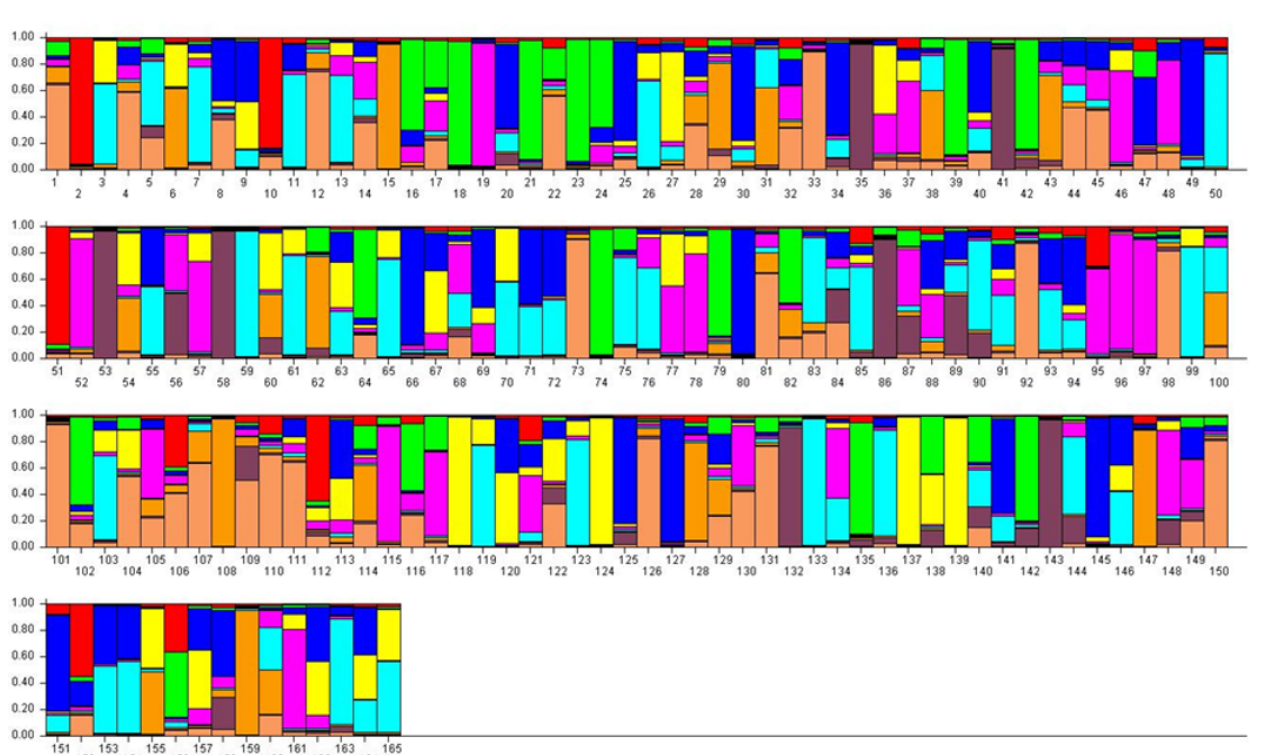
Figure 4. Bar plot of the results from a Bayesian genetic structure analysis with K = 9, dusty pink RPP9:1, orange RPP9:2, red RPP9:3, green RPP9:4, brown RPP9:5, dark blue RPP9:6, pale blue RPP9:7, yellow RPP9:8, purple RPP9:9. For accession names, see Supplementary Table 1.